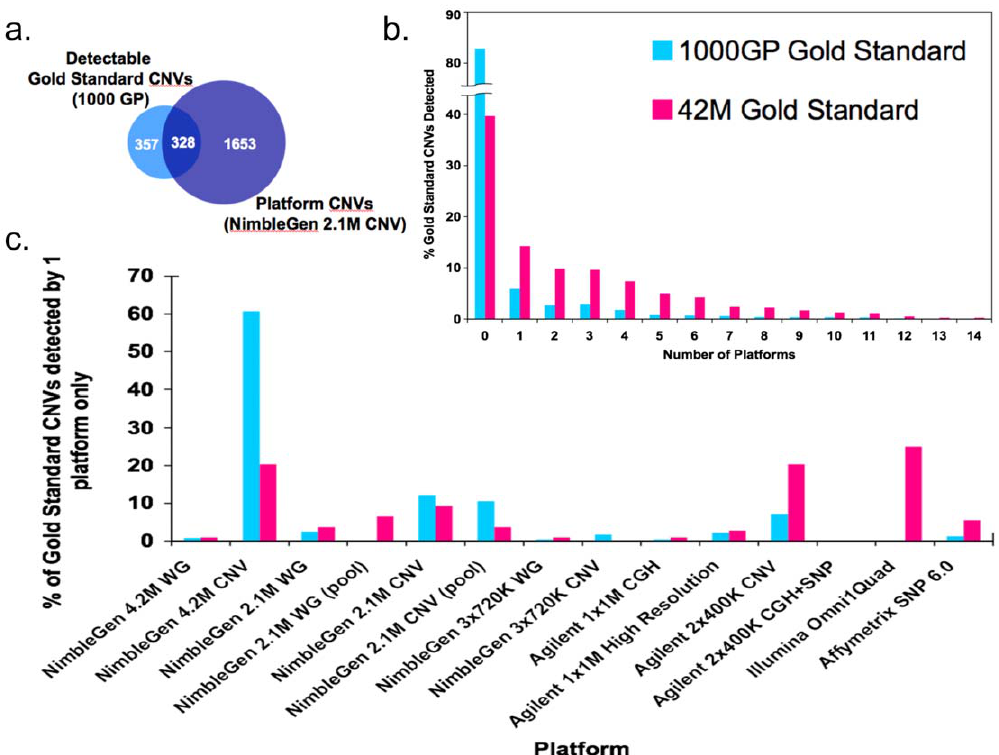
Figure 5. Array detectable Gold Standard CNVs. (a) Venn diagram showing overlap of CNV calls from a single platform (NimbleGen 2.1 M CNV) with the detectable 1000 Genomes Gold Standard. (b) The percentage of Gold Standard CNVs that were detected by at least one technical replicate of each platform is shown for all platforms (including twelve different platforms and two conditions for the NimbleGen 2.1 M arrays). Blue bars indicated percentage of 1000GP GS CNVs and pink bars indicate percentage of 42 M GS CNVs. (c) Platform distribution of all Gold Standard CNVs that are detected by only one platform.